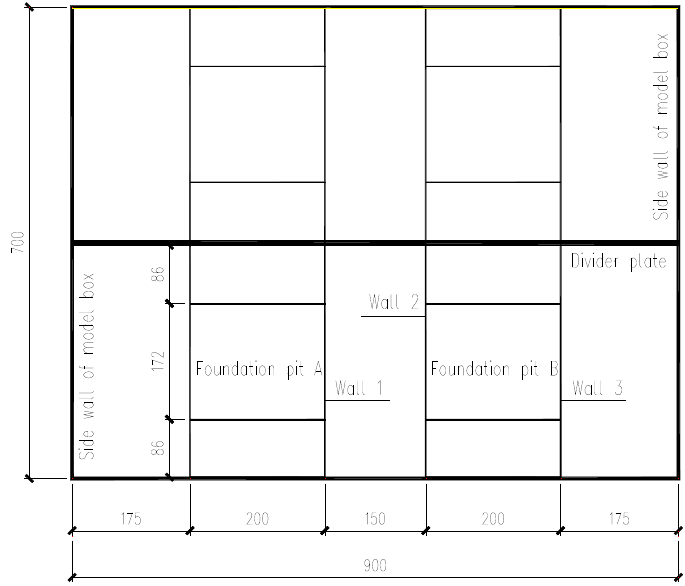
Figure 1. Layout plan of the model test.